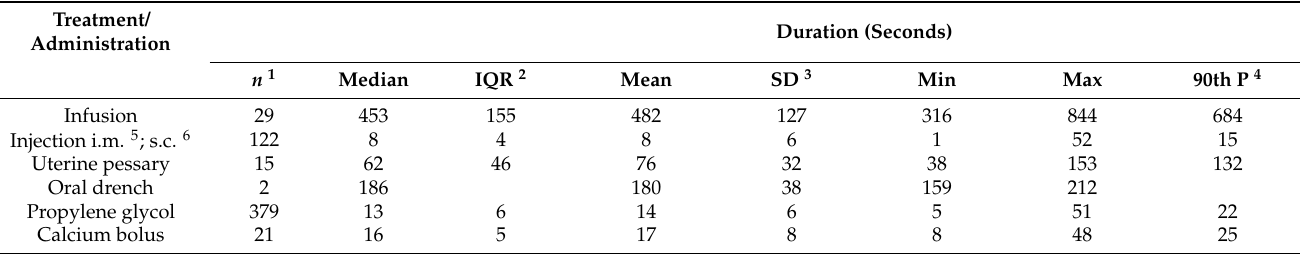
Table 6. Duration of the individual treatments (from all three